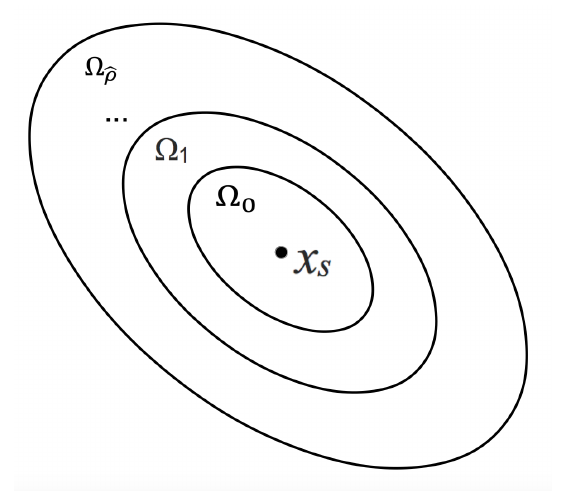
Figure 5. Schematic of different regions inside Ω ˆ ρ